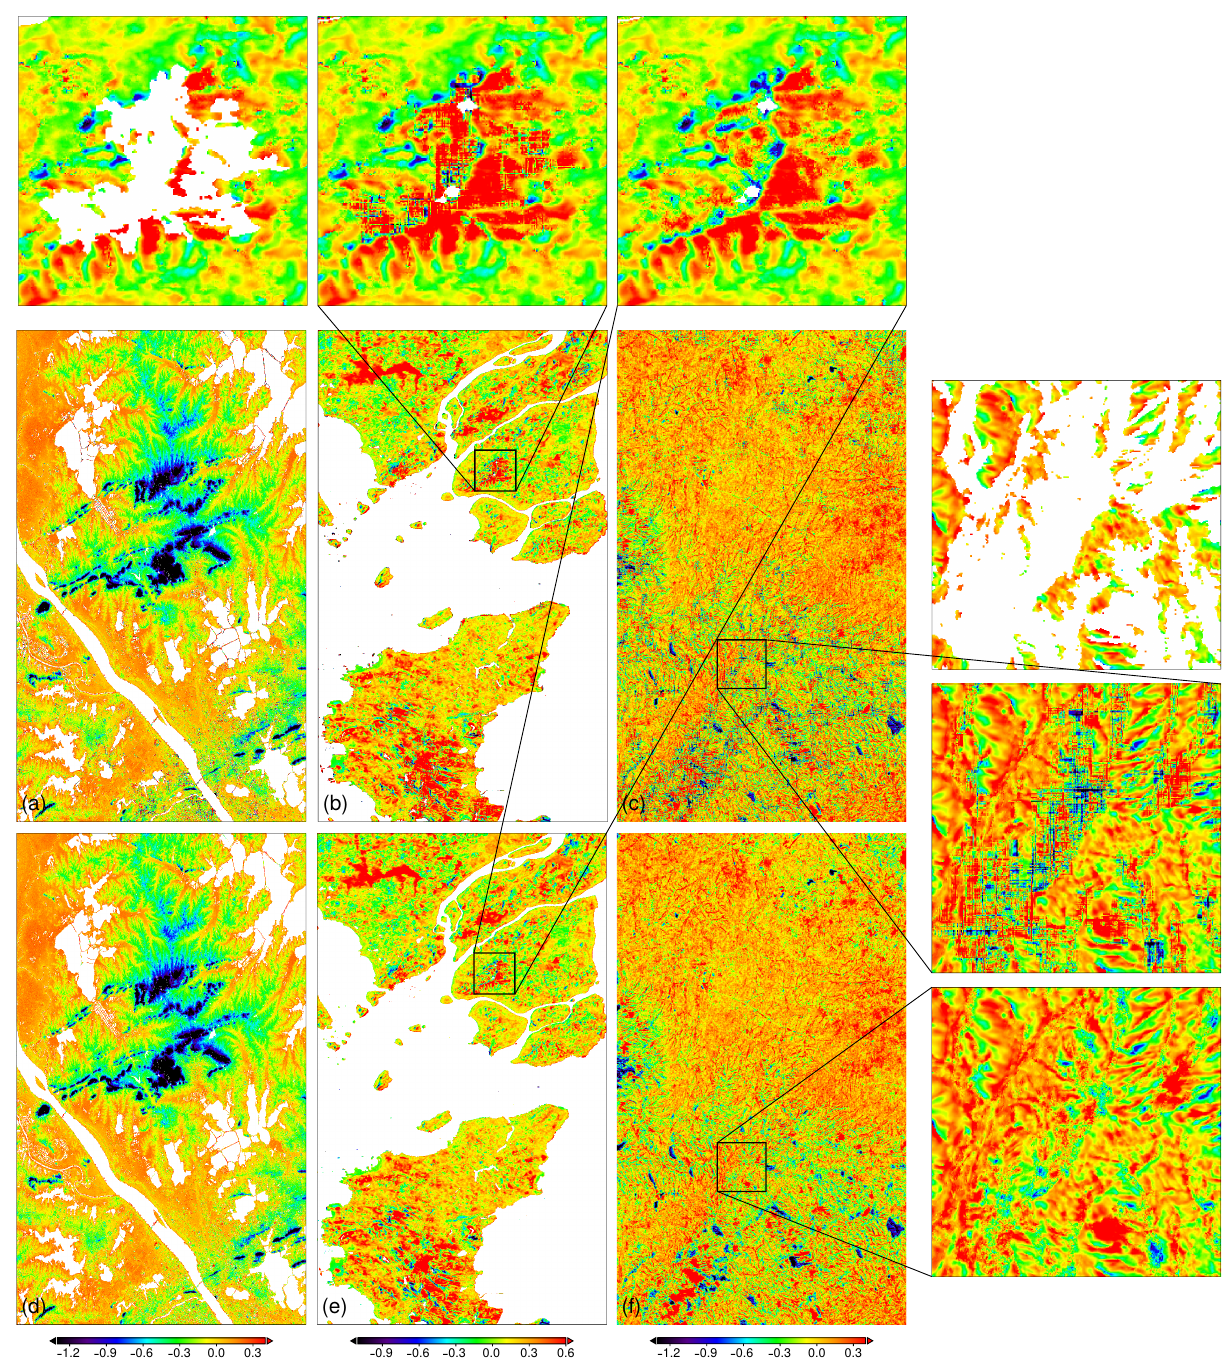
Figure 13. The initial unwrapped phase outside the continuous regions from PCR for Wuhan ( a ), Singapore ( b ), and Songshan ( c ) and their final version ( d – f ) with 1000 times of nonlinear diffusion, respectively. The detailed local unwrapped phase in the regions shows the unwrapped version and diffusion version of the areas